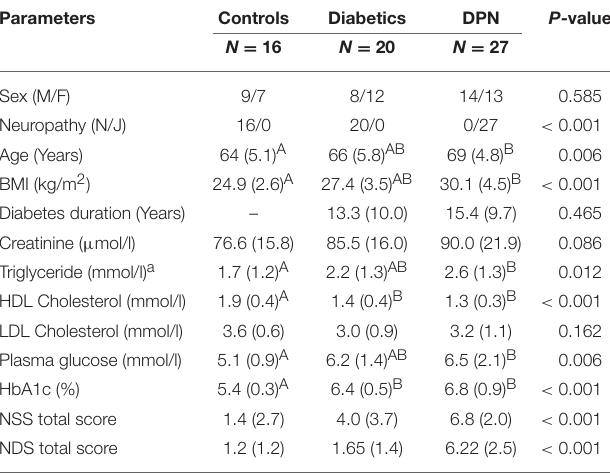
TABLE 1 | Clinical characteristics of the study population. Parameters